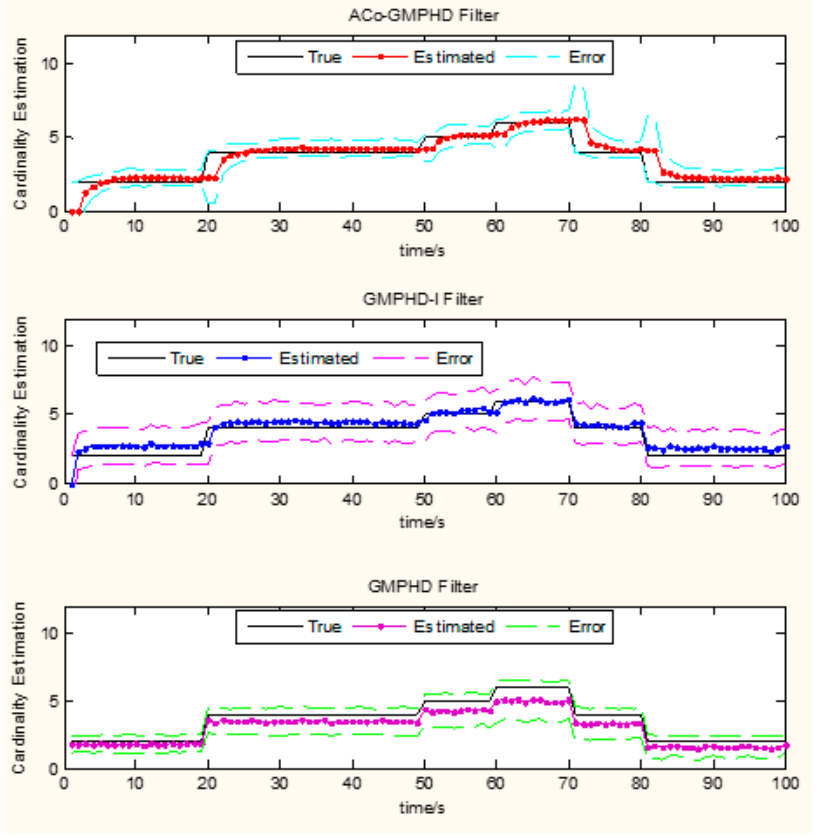
Figure 5. Monte Carlo average estimates of the number of targets. Estimated number ( solid lines ), standard deviation ( dashed lines ).